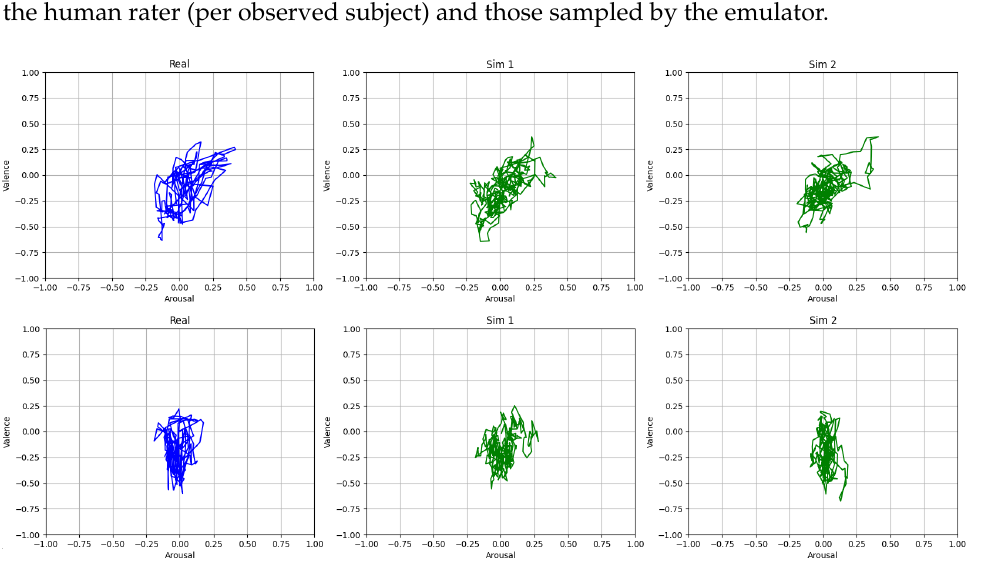
Figure 4. V/A trajectories from subjects P30 ( top ) and P34 ( bottom ) as annotated by human raters (in blue) and two emulated raters for each subject (in